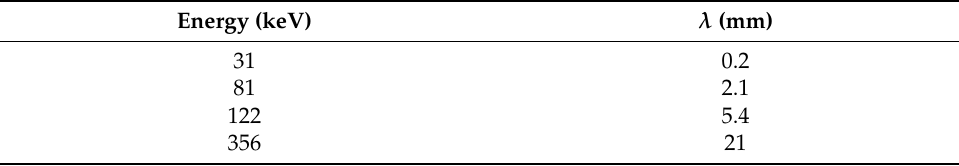
Table 2. Mean free path for gamma emissions in CRY018